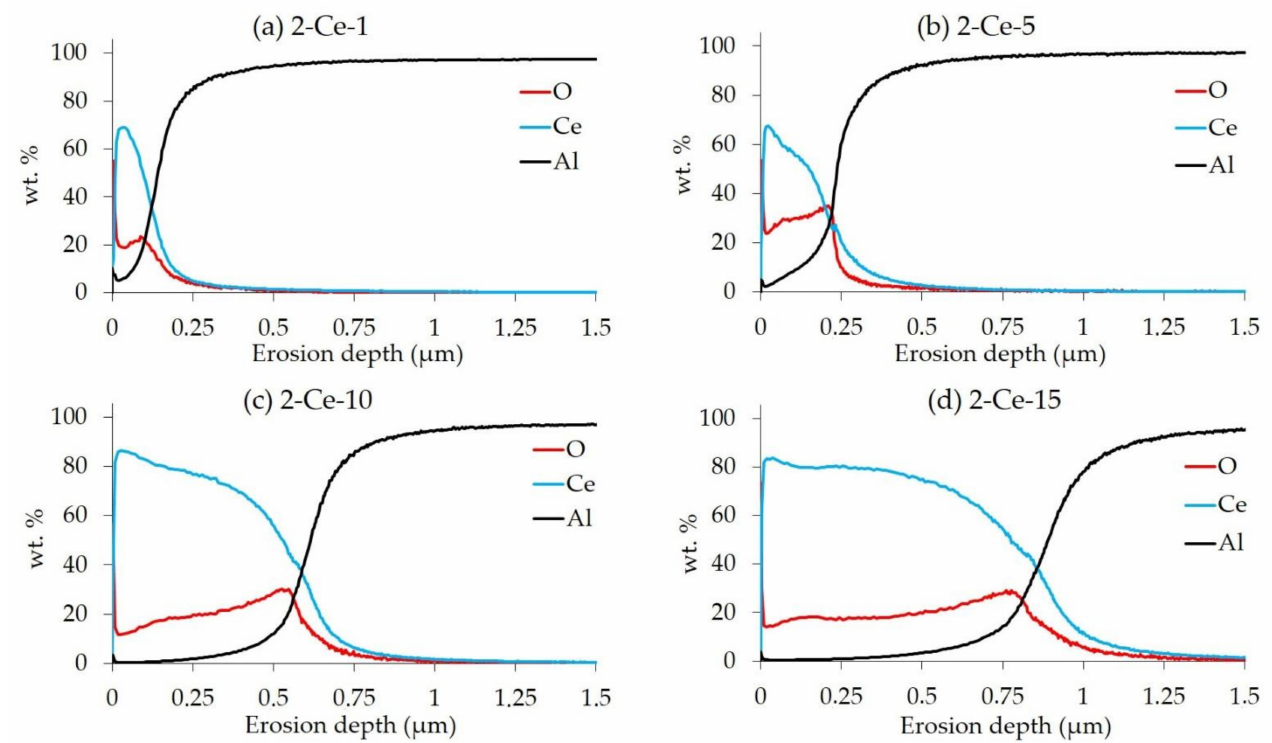
Figure 3. GDOES depth profiles of 2024 samples: ( a ) 2-Ce-1, ( b ) 2-Ce-5, ( c ) 2-Ce-10, and ( d ) 2-Ce-15.